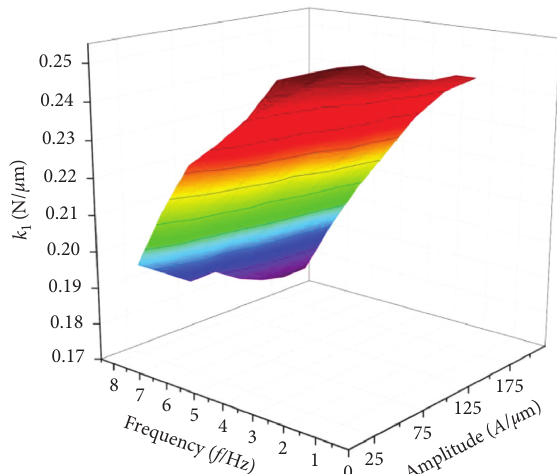
Figure 10: The space surface of stiffness coefficient k